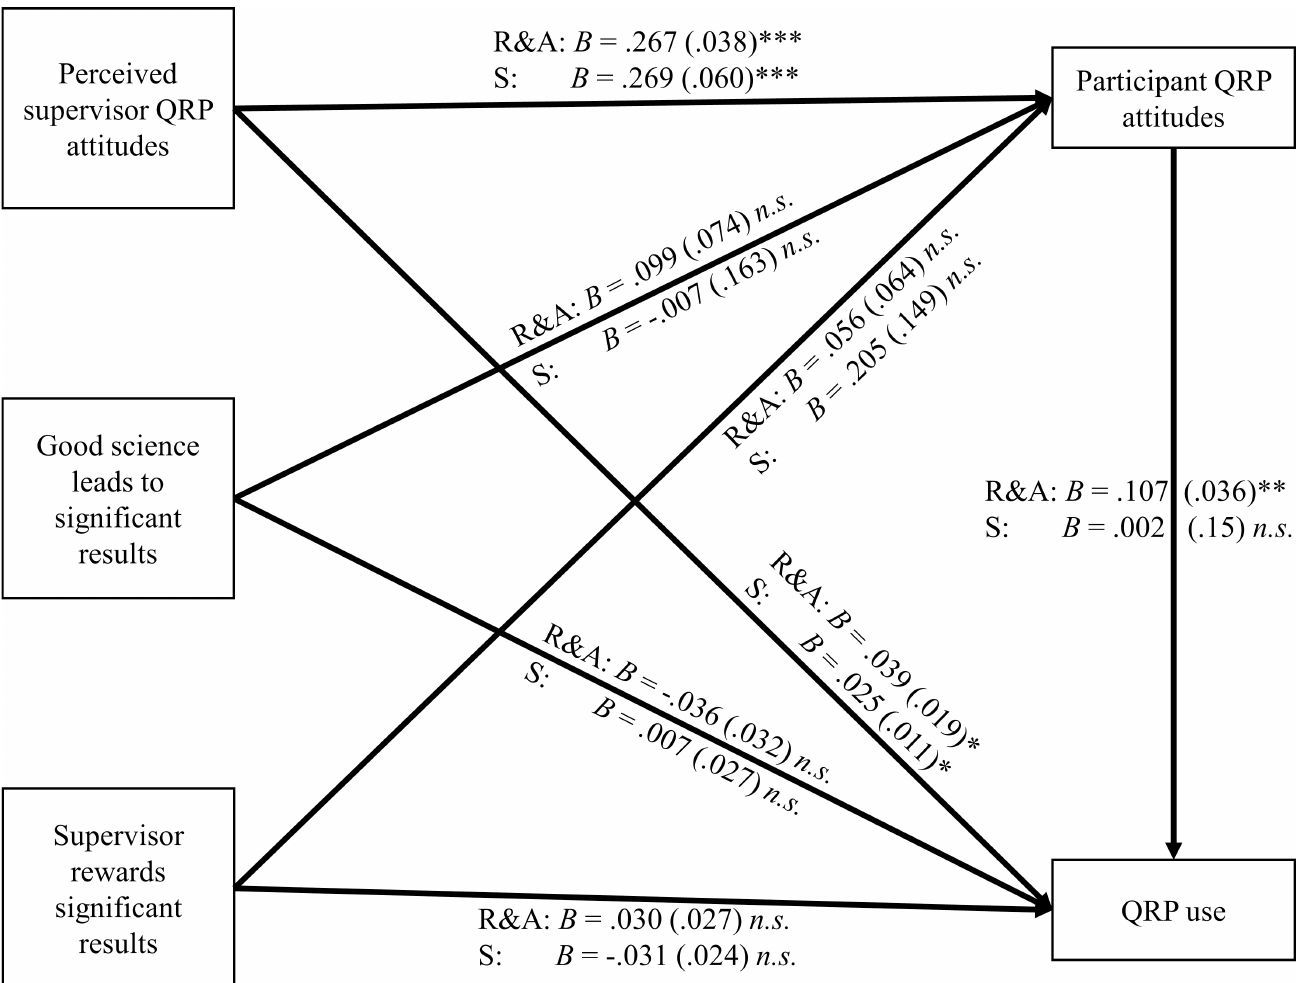
Fig 2. Regression weights for mediation models predicting self-reported reporting and analysis (R&A) and study design (S) QRP use. Standard errors are given in parentheses. Asterisks denote statistical significance: (cid:3) : p < .05, (cid:3)(cid:3) : p < .01, (cid:3)(cid:3)(cid:3) : p < .001.